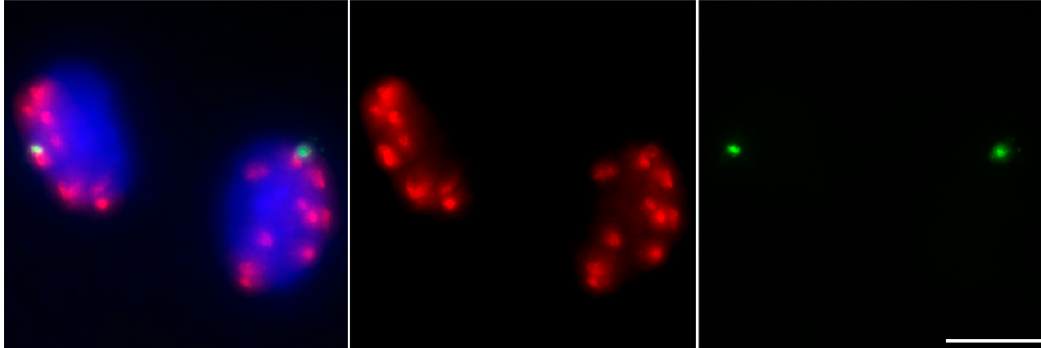
Figure 3. Labeling of phH2AThr133 in maize B mini-chromosome #9. The distribution of phH2AThr133 signals at telophase I stage of meiosis for maize B mini-chromosome #9. DAPI-stained chromosomes are blue, phH2AThr133 are red, and B-repeats are green. Bar = 10 μ m. The B-repeat signals distributed in two cells in telophase I indicate that the sister chromatids of this mini-chromosome previously separated in anaphase I.